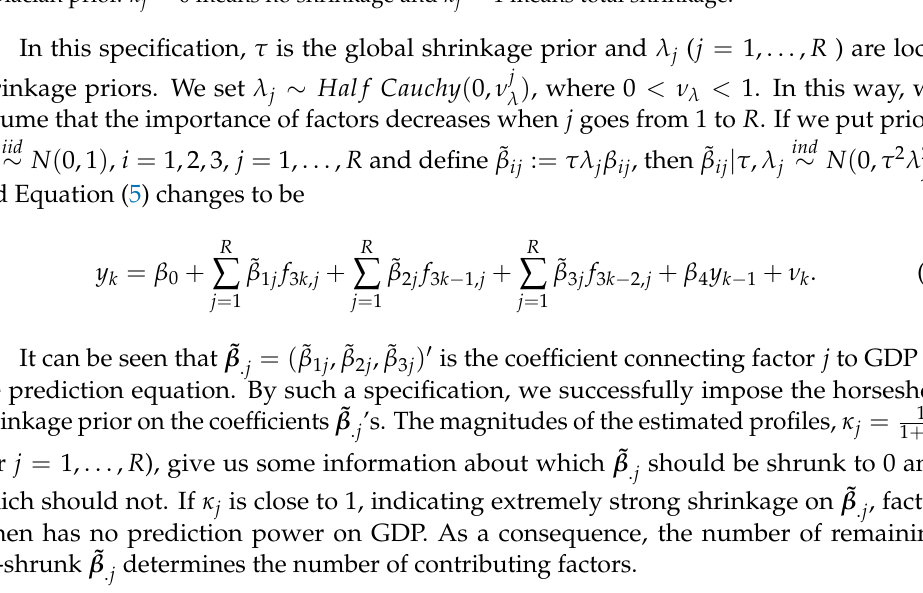
Figure 2. Densities of the shrinkage profile κ j based on the horseshoe prior, the t prior, and the Laplacian prior. κ j = 0 means no shrinkage and κ j = 1 means total